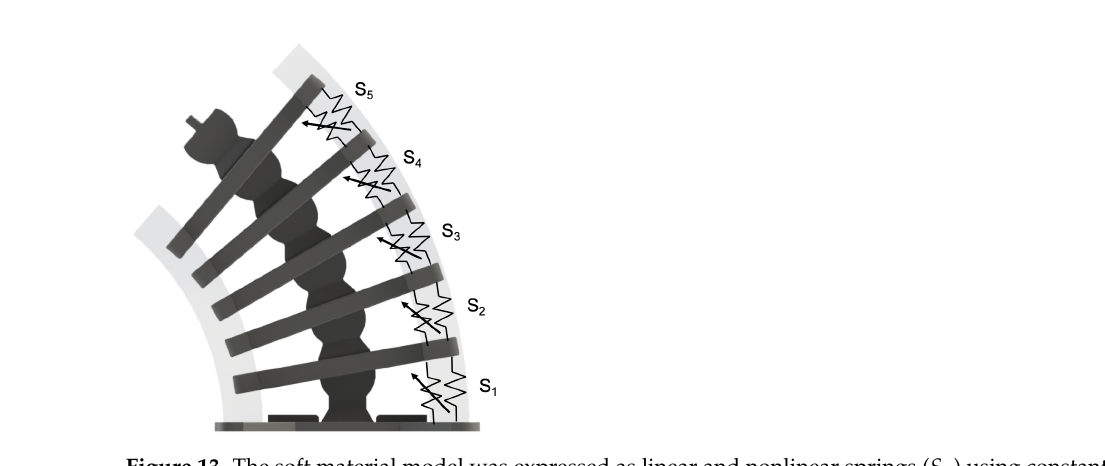
Figure 13. The soft material model was expressed as linear and nonlinear springs ( S n ) using constant and tunable resistive elements,